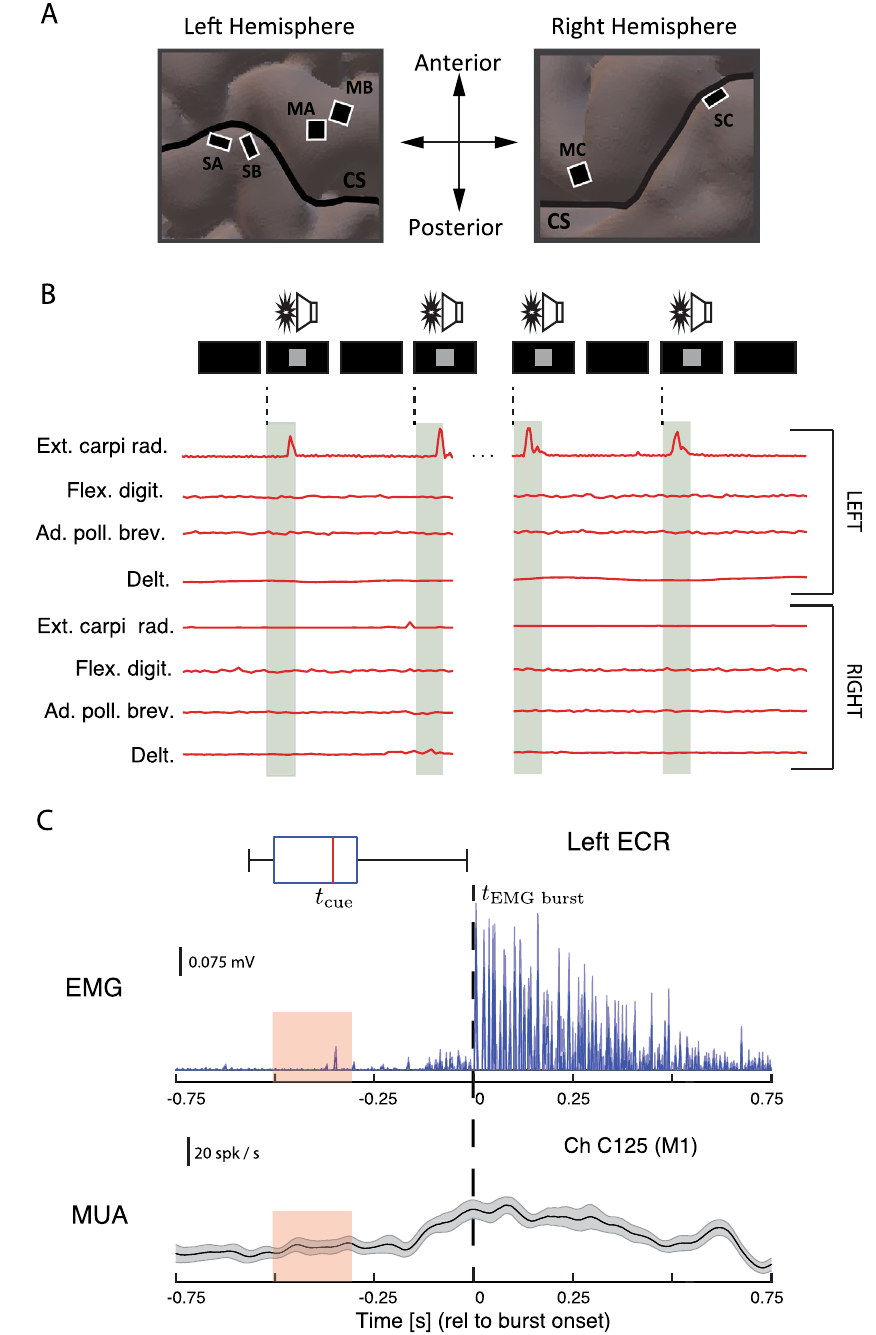
Figure 1. Cortical recording sites and experimental methods. ( A ) Sites of the six bilaterally-implanted microelectrode arrays (MEAs), overlaid on MRI reconstruction of participant’s brain (CS: central sulcus). Arrays are labeled by anatomical target and pedestal (e.g. MA: primary motor cortex, pedestal A; SB: primary sensory cortex, pedestal B). ( B ) Experimental paradigm. Isolated muscle contractions (or contraction attempts) were cued by metronome ticks (click and pixel flash) at 4-s intervals. Electromyography (EMG) traces are from 4 example trials (repetitions), where the participant executed left extensor carpi radialis (ECR) contractions without co-contracting neighboring or opposite-limb muscles. ( C ) Temporal referencing and synchronization of neuromuscular and cortical data for a representative EMG-producing muscle (the left extensor carpi radialis: ECR). The upper plot shows event-referenced raw EMG in mV (reference line). Box plot shows movement cue time distributions relative to burst onset; pink regions are the interquartile range (IQR) of this distribution. The lower plot shows the peri-event time histograms (PETH) of multiunit activity (MUA) from an example motor channel on the contralateral motor array, in spikes/sec. Signals were referenced to EMG burst onset (dashed line; see Supplementary Information), and are trial averaged. Shaded regions show bootstrapped 95%–confidence